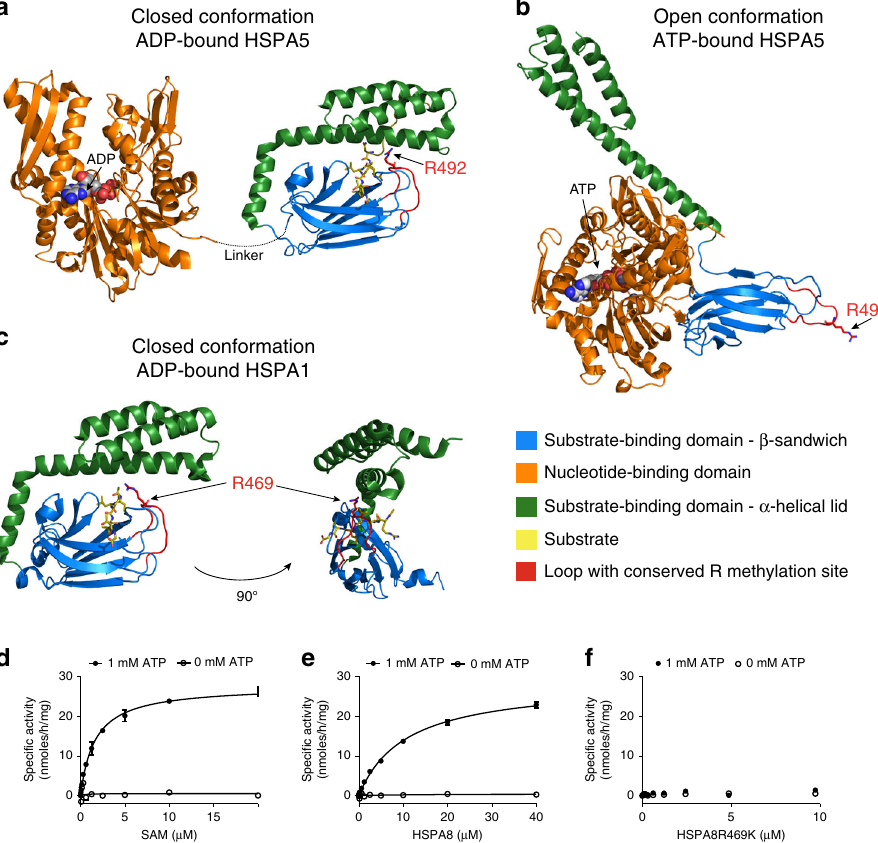
Fig. 4 PRMT7 monomethylation of HSP70 depends on the open (ATP-bound) form of HSP70. a – c HSP70 structures in closed and open con fi rmations reveal differential accessibility of the conserved R469-containing sequence (HSPA8) monomethylated by PRMT7. Structures are color coded for domains (orange — ATP binding, blue — substrate binding, and green — lid domains). The HSP70 substrate-binding domain loop containing PRMT7 methylated arginine is colored red. a , b Closely related homolog HSPA5 structures (65% overall sequence identity to HSPA8) were analyzed to investigate the position of the arginine methylation site in the different conformations. In the ADP-bound state, the lid of the substrate-binding domain is closed (PDB 5E85), limiting accessibility of the R492 (analogous to R469 in HSPA8) residue for methylation by PRMT7. In the ATP-bound form (PDB 5E84), the arginine residue is accessible therefore permitting access by the PRMT7 enzyme. c The structure of the more closely HSPA8 related HSPA1A (86% overall sequence identity and 82% sequence identity for aa. 386 – 646 in the substrate-binding domain, PDB 4PO2) in the closed conformation in which R469 is occluded by the lid subdomain. d – f Kinetic analysis of HSPA8 methylation by PRMT7 in vitro. Kinetic parameters were determined for HSPA8 methylation in the presence and absence of ATP. PRMT7 had no activity in the absence of ATP. d Kinetic analysis at fi xed 10 µ M HSPA8 (SAM K m = 1.6 ± 0.1 µ M). e Kinetic analysis at fi xed 20 µ M of SAM (HSPA8 K m = 10.6 ± 0.1 µ M and k cat of 2.2 ± 0.1 h − 1 ). f HSPA8 – R469K mutant is not methylated by PRMT7 in vitro. The results are mean ± SEM of three technical replicates. Source data are provided as a Source Data fi